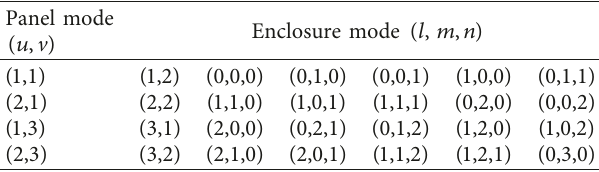
Table 2: Panel modes and enclosure